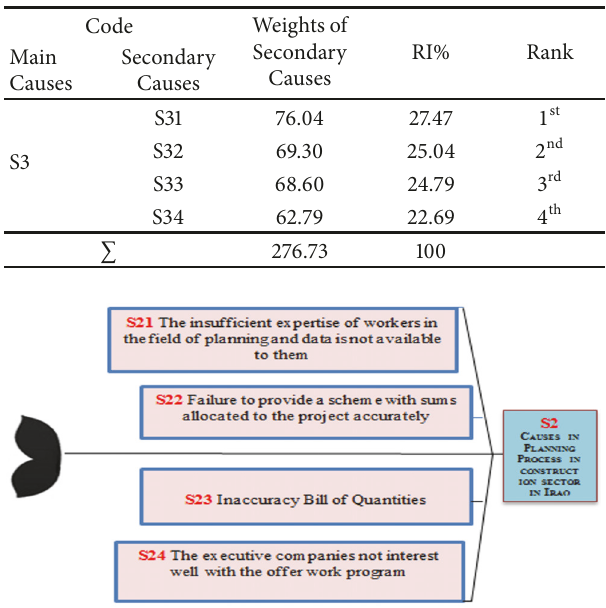
Figure 5: Fishbone diagram of the project planning management process group.